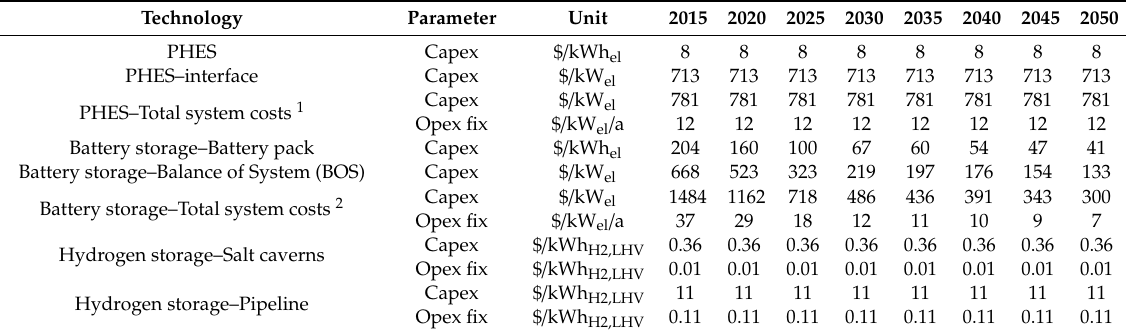
Table A6. Investment costs of storage systems (all costs are in US$2018). Data based on